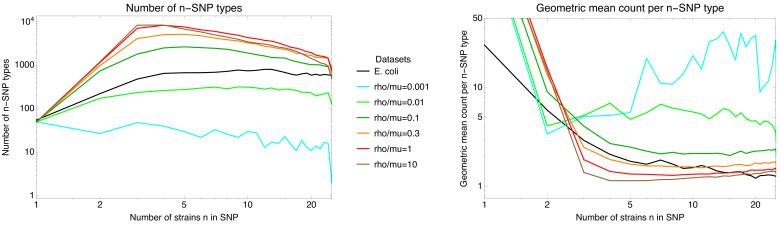
Diversity of n-SNPs.Left panel: Number of n-SNP types (vertical axis) as a function of n (horizontal axis) for the E. coli data (black line) and for simulations with different recombination to mutation rates ρ/μ (colored lines, see legend). Both axes are shown on a logarithmic scale. Right panel: Geometric average of the number of occurrences per n-SNP type (vertical axis) as a function of n for the E. coli data (black line) and for simulations with different recombination to mutation rates ρ/μ (colored lines, see legend). Both axes are shown on a logarithmic scale. Note that, in order to better show the heights of the curves for the different datasets the vertical axis is clipped at 50. For the simulated datasets, the geometric mean of the 1-SNP counts runs from 400 to 1000.